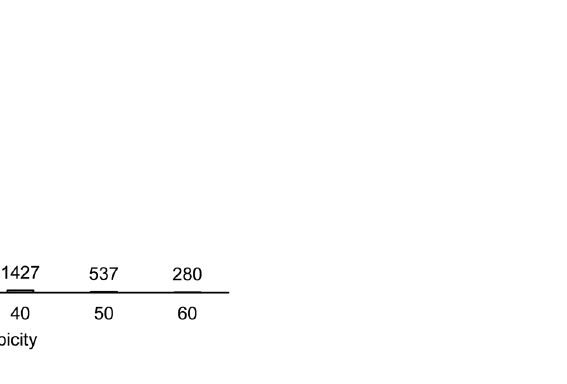
Figure 7. Hydrophobic nature of